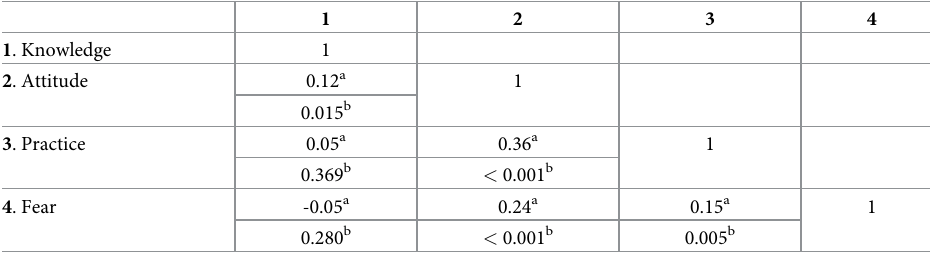
Table 6. Results of spearman’s rank-order correlation among knowledge, attitude, practice, and fear score.